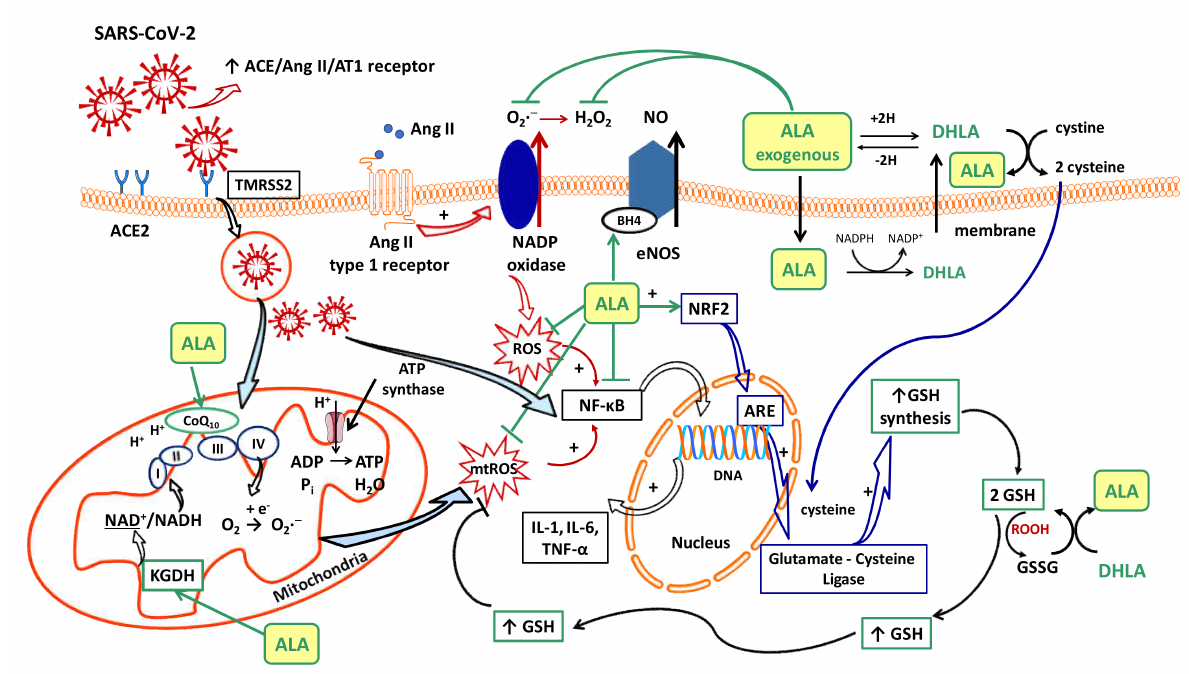
Figure 1. The implications of SARS-CoV-2 infection in cellular redox status and cellular homeostasis, the main therapeutic targets of ALA in this context. The SARS-CoV-2 infection is initiated by the binding of S protein to ACE2 (the receptor of SARC-CoV-2), followed by its priming to the cell membrane (via TMRSS2) and by virus endocytosis. During infection, the ACE-Ang II-AT1 receptor signaling pathway is overactivated, which in turn activates NADPH oxidase with the increase production of O 2 • − . The enhancement in mtROS synthesis adds to this, both processes influencing the cellular redox status, endogenous antioxidant level and, subsequently, cellular homeostasis. In addition, the excess of ROS contributes to the activation and nuclear translocation of NF- κ B factor, increasing production of pro-inflammatory cytokines and enhancing the pro-inflammatory process. Intracellularly, ALA is reduced to DHLA. The ALA/DHLA redox system interferes with several signaling pathways of OS, even with the inflammatory process, and may present some protection in a SARS-CoV2 infection. Due to its wide distribution, ALA can directly scavenge the ROS, or can restore the reduced form of glutathione or CoQ10, an important constituent of the mitochondrial electron transport chain, thus enhancing endogenous antioxidant protection. Moreover, ALA stimulates GSH synthesis by increasing cellular cysteine uptake and by activating the NRF2-ARE signaling pathways, increasing glutamate–cysteine ligase activity. As cofactor of mitochondrial KGDH, ALA influences the supply with reducing equivalents (NAD + /NADH). Dependent on its antioxidant properties, but also independent of them, the ALA/DHLA system inhibits NF-kB signaling with the decrease in pro-inflammatory cytokine secretion. By preventing the oxidative depletion of BH4, an essential cofactor of eNOS, ALA can restore the eNOS activity with an increase of NO bioavailability, and thus, it improves the endothelial function. (ACE2—angiotensin-converting enzyme